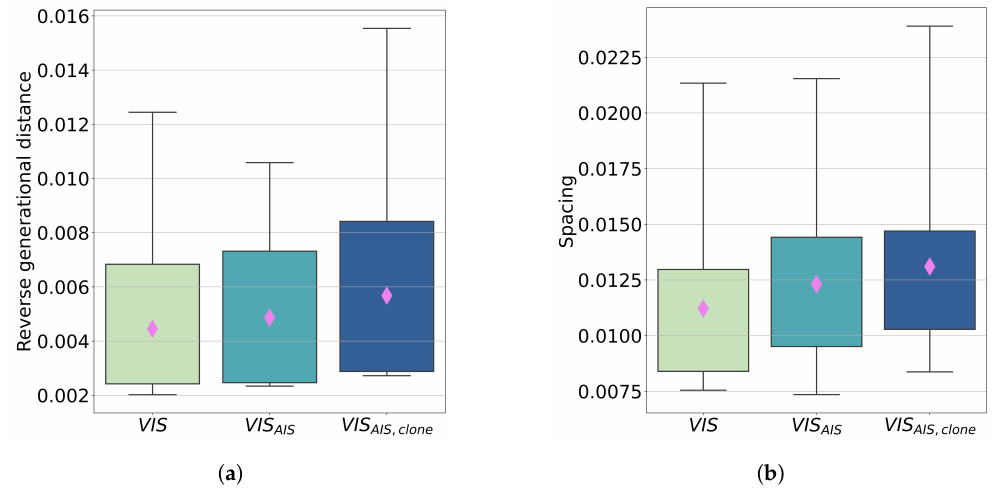
Figure 10. ( a ) Box plots of the reverse generational distance index for the 30 runs of the three tested approaches. The pink diamonds represent the mean value of each case; ( b ) Box plot of the spacing index for the 30 runs of the three tested approaches. The pink diamonds represent the mean value of each